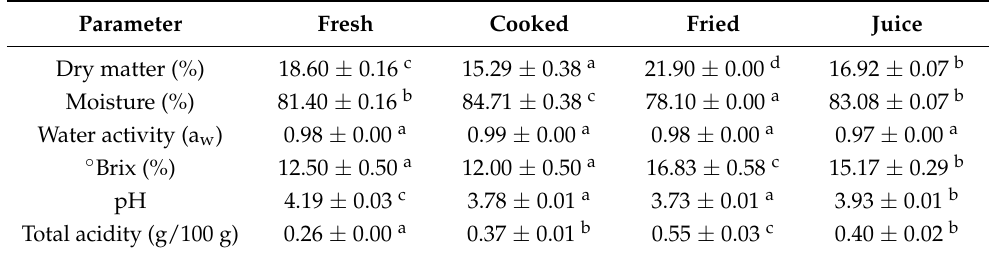
Table 2. Physicochemical characteristics of fresh quince fruit and its products.